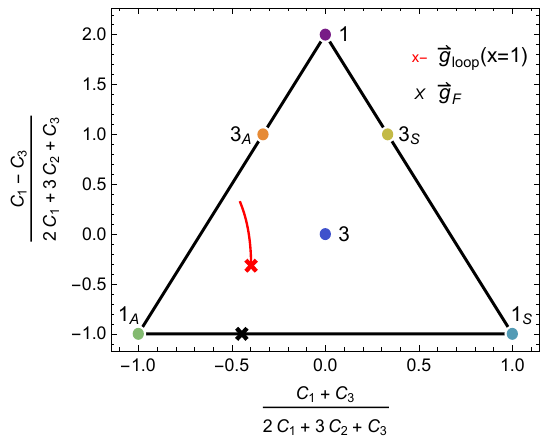
Figure 20. Generators of the positivity cone for four-Higgs operators. The black cross represents ~g F , the contribution from heavy fermion cuts. The red cross corresponds to ~g loop (1) = ~g F + ~g q , adding the contribution of SM fermion cuts starting from 4 M 2 and up. The red curve shows ~g as x decreases from 1 to 0.1, which incorporates, on top of ~g , the SM particle cuts from ( (cid:15) Λ) 2 to 4 M 2 . See discussion in